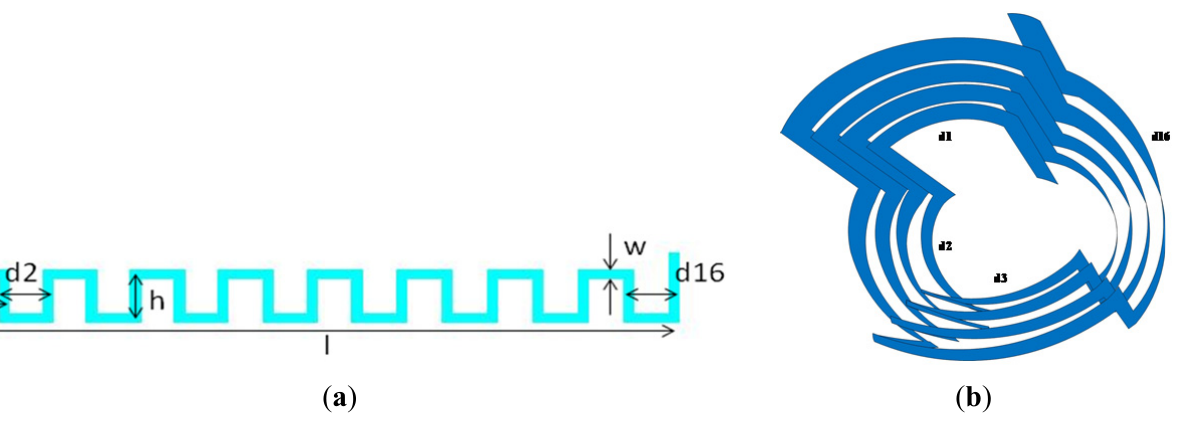
Figure 1. Designed meander inductor for internal sensor’s coils—( a ) unrolled, in the plane and ( b ) rolled,